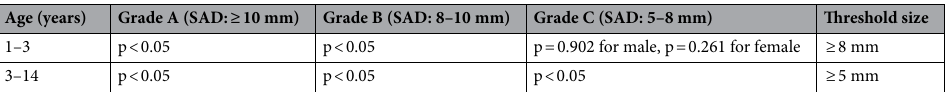
Table 2. Recommended threshold sizes for E-ALNs in different age